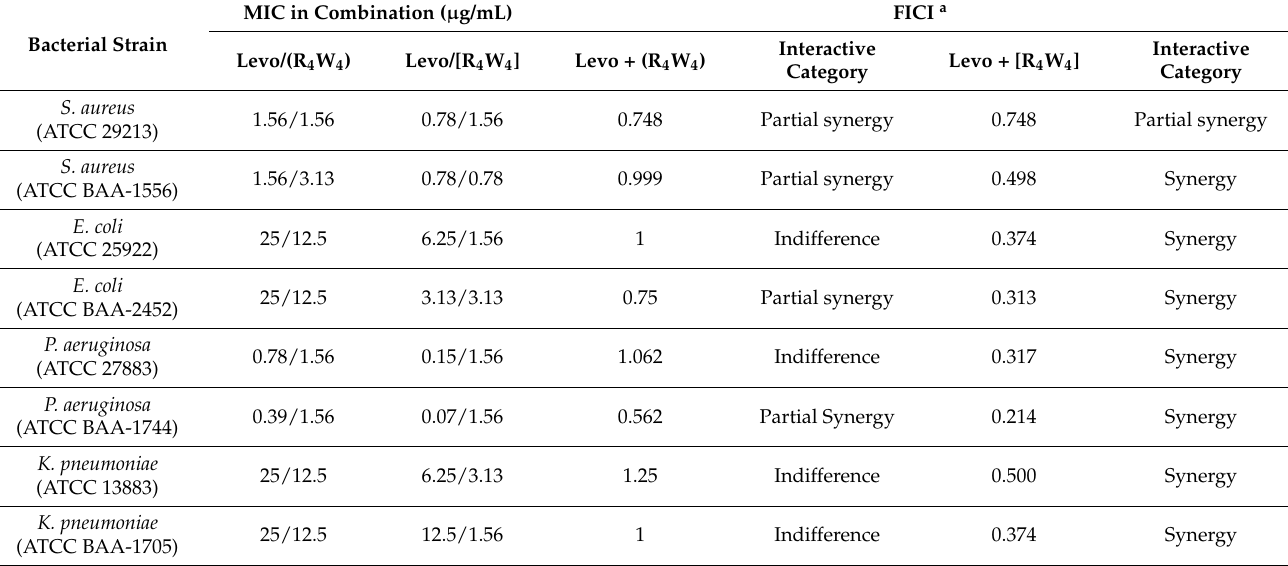
Table 2. Checkerboard assay using a combination of Levo and